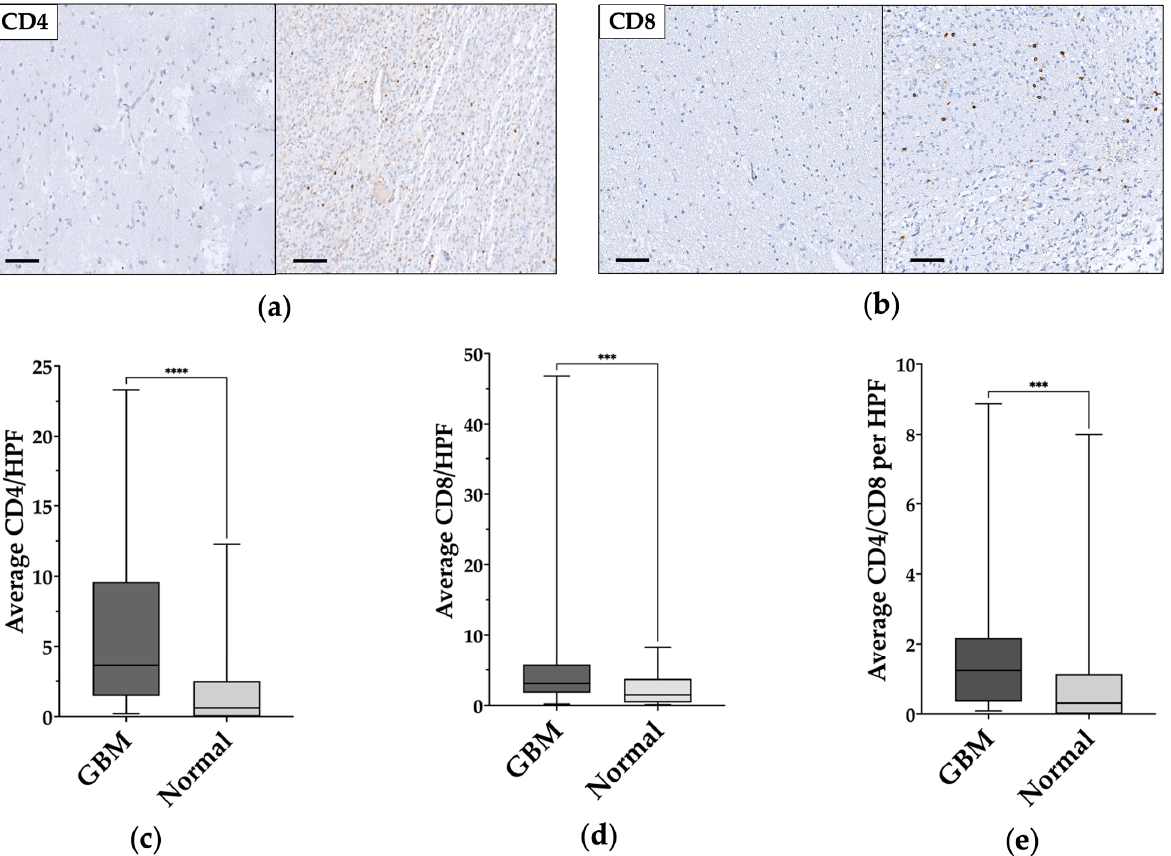
Figure 3. CD4+ and CD8+ cells comparison in normal-appearing tissue and in glioblastoma samples. ( a , b ) Immunohistochemical staining shows the low levels/absence of CD4+ and CD8+ in normal-appearing tissue on the left and tumor-infiltrating lymphocytes (TILs) in glioblastoma on the right. Magnification of all images 200 × . Scale bar: 100 µ m. ( c – e ) Statistically significant CD4+, CD8+, and CD4/CD8 differences between normal-appearing tissue and glioblastoma (GBM) samples. ***: p ≤ 0.001; ****: p ≤ 0.0001.